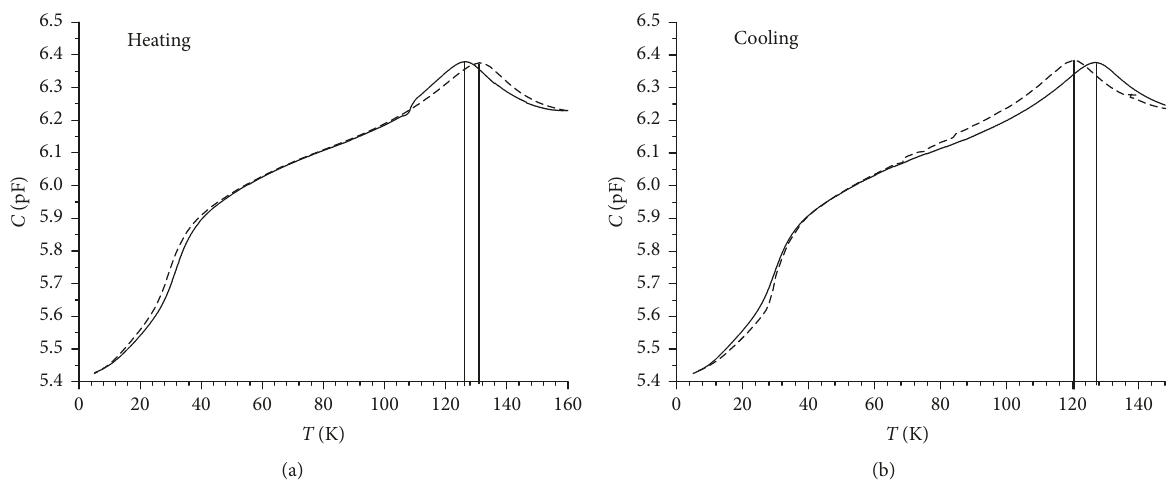
Figure 10: Temperature dependence of capacitance 𝐶 for S3 + KDP nanocomposite: (a) on heating in zero field (solid line) and at B = 10T (dash line); (b) on cooling in zero field (dash curve) and at B = 10T (solid curve). Vertical lines indicate the positions of maximum on the 𝐶(𝑇)